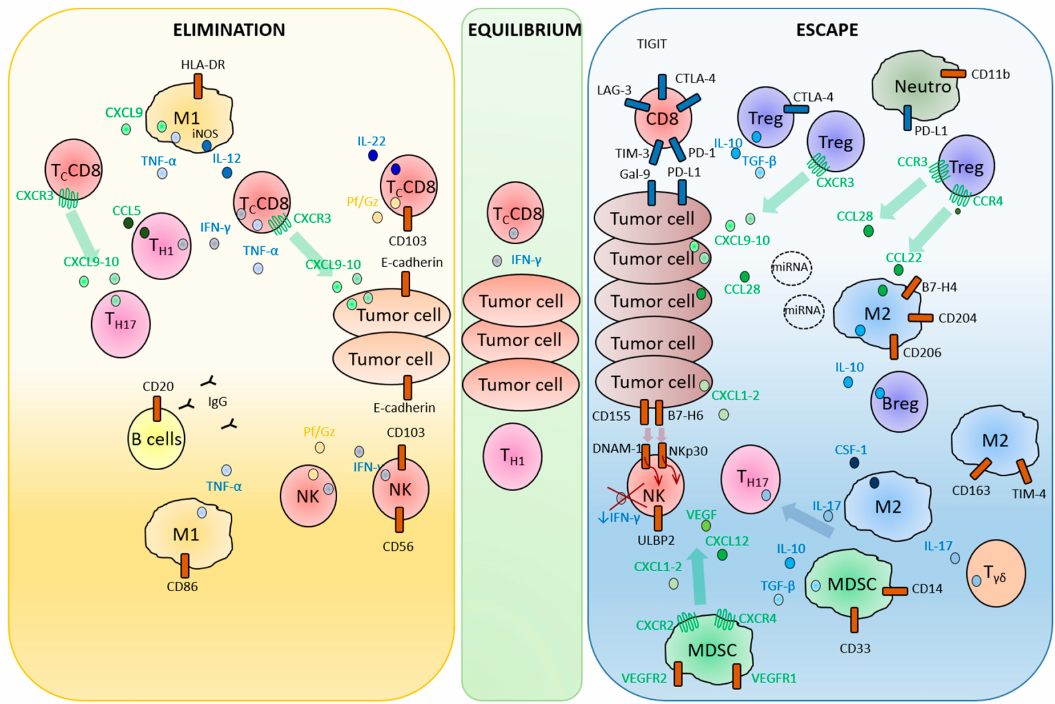
Figure 1. The immune landscape of epithelial ovarian cancer (EOC): cells, mechanisms and factors involved in tumor elimination or escape. EOC tumor elimination implicates cytotoxic cells, such as cytotoxic CD8 + T-cells (T C CD8) or natural killer (NK) cells, that produce cytolytic perforin / granzymes (Pf / Gz), and various e ff ector cytokines and CD20 + B cells, as well as IgG-producing plasmocytes. T C CD8 are recruited to the tumor site via chemokine receptor expression and chemokines released in the microenvironment by other cells, including T H 17. Both T C CD8 and CD56 + NK cells are retained at the tumor site through CD103–E-cadherin interactions. Finally, myeloid cells such as CD86 + HLA-DR + type-1 polarized macrophages (M1) perform antitumor roles through iNOS enzyme expression, secretion of TNF- α and T H 1-T C CD8-stimulating cytokine IL-12. The intermediate equilibrium phase involves adaptive immunity components, in particular INF- γ + TcCD8 and Th1 cells. In contrast, cells such as regulatory CD4 + T-cells (Treg), type-2 macrophages (M2), B regulatory cells (Breg), myeloid-derived suppressor cells (MDSC), suppressive neutrophils (Neutro), IL-17-producing γδ T-cells (T γδ ) and T H 17 generate an immunosuppressed microenvironment, favoring tumor escape. Treg are recruited to tumors via CXCL9, CXCL10, CCL28 or M2-secreted CCL22, and prevent antitumor response through IL-10, TGF- β and cell–cell contact-dependent mechanisms. In addition, M2 produce miRNA-containing exosome, IL-10 and CSF-1, all of which promote tumor progression. MDSC are recruited to tumors through vascular endothelial growth factor receptor (VEGFR)1, VEGFR2, CXCR2 and CXCR4 expression, and VEGF, CXCL1, CXCL2 (CXCL1-2) and CXCL12 in the microenvironment. Breg and MDSC also secrete immunosuppressive IL-10 and TGF- β . Their recruitment, together with M2, is increased through T H 17-secreted IL-17. Finally, T C CD8 and NK cells’ antitumor functions are inhibited via checkpoint expression, and via downregulation of DNAM-1 and NKp30, following binding with tumor cells-expressed CD155 and B7-H6, thus triggering downregulation of IFN- γ